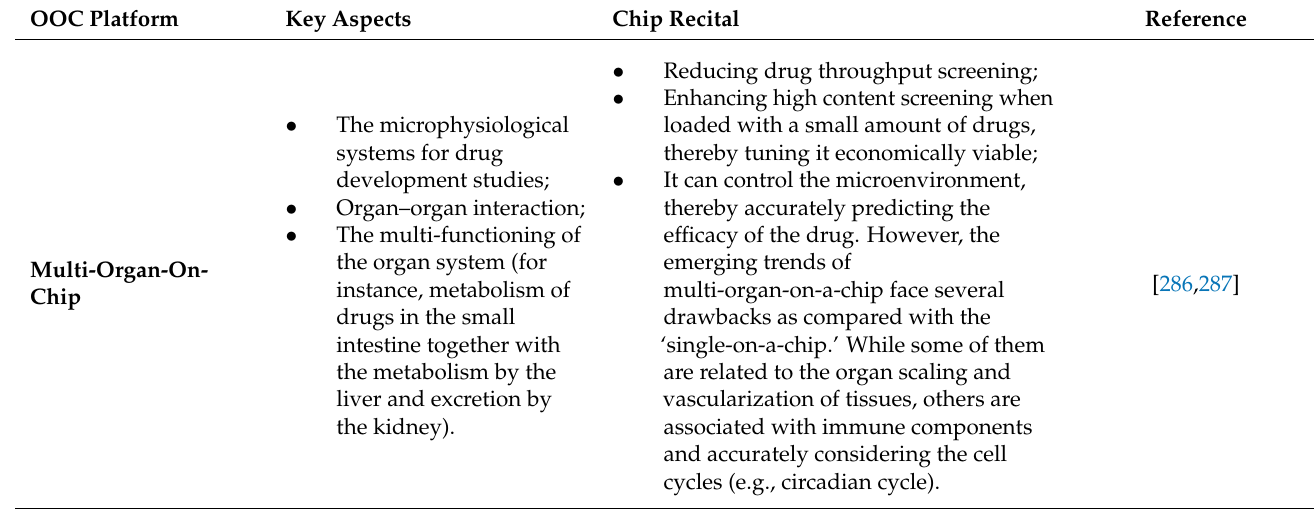
Table 4. Multi-organ-on-a-chip: Key aspects and chip presentation. OOC